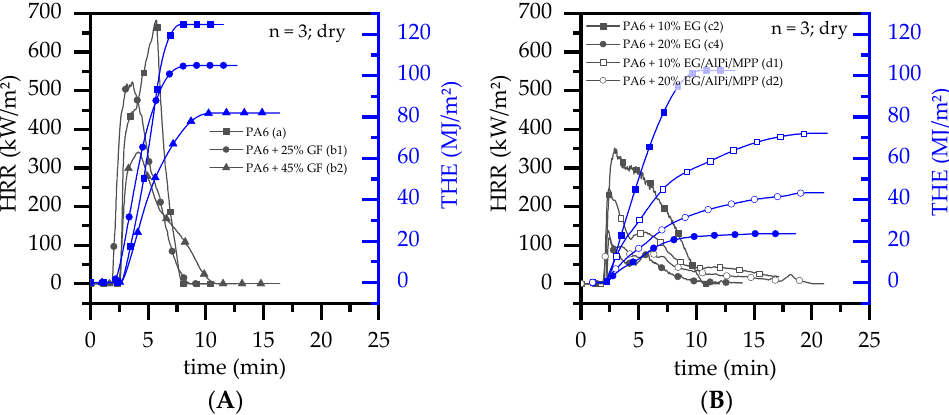
Figure 4. Representative selection of cone calorimeter (50 kW/m 2 ) results displayed over time for ( A ) net PA6 and PA6 containing GF as reference and ( B ) PA6 containing EG or EG/AlPi/MPP. Results shown refer to dry-conditioned samples.